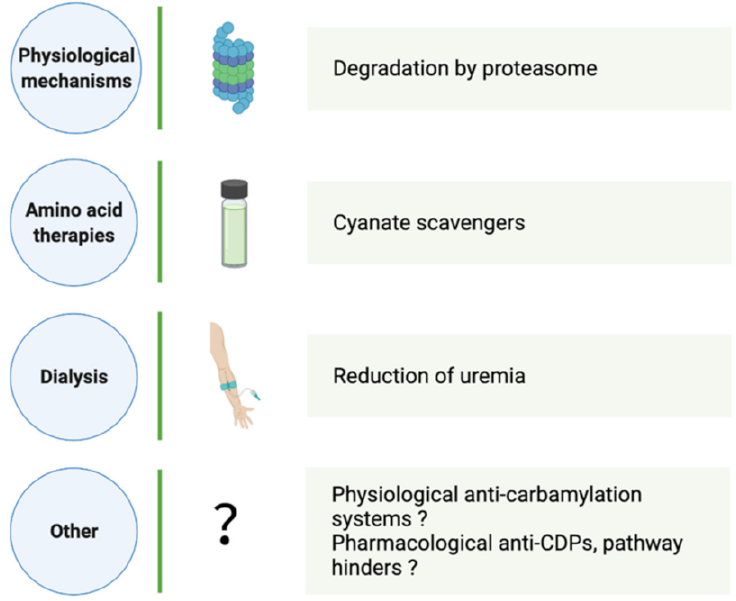
Figure 2. Mechanisms and strategies to limit the carbamylation process and to reduce CDP accumu- lation. CDP: carbamylation-derived